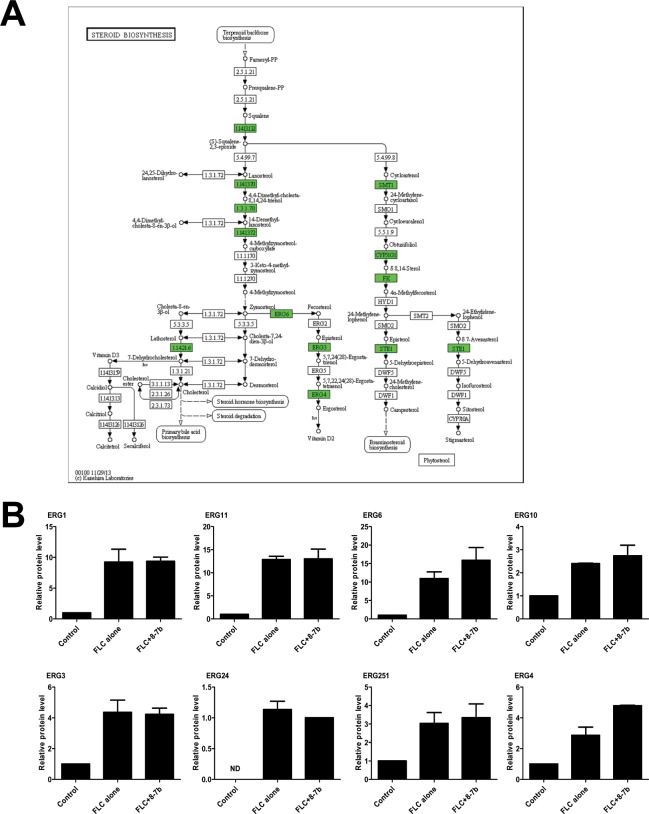
The significant steroid biosynthesis pathway (p<0.05) for differential proteins and the differential protein level in Comparison 1 and 2.(A) For each rectangular shape, green shapes indicate significantly up-regulated proteins. KEGG pathway analysis figure depicts the role or involvement of a specific protein or a family of related proteins at a particular location in the pathway. (B) The relative protein level of eight differential proteins compared to Control, corresponding to green rectangular shapes in A.